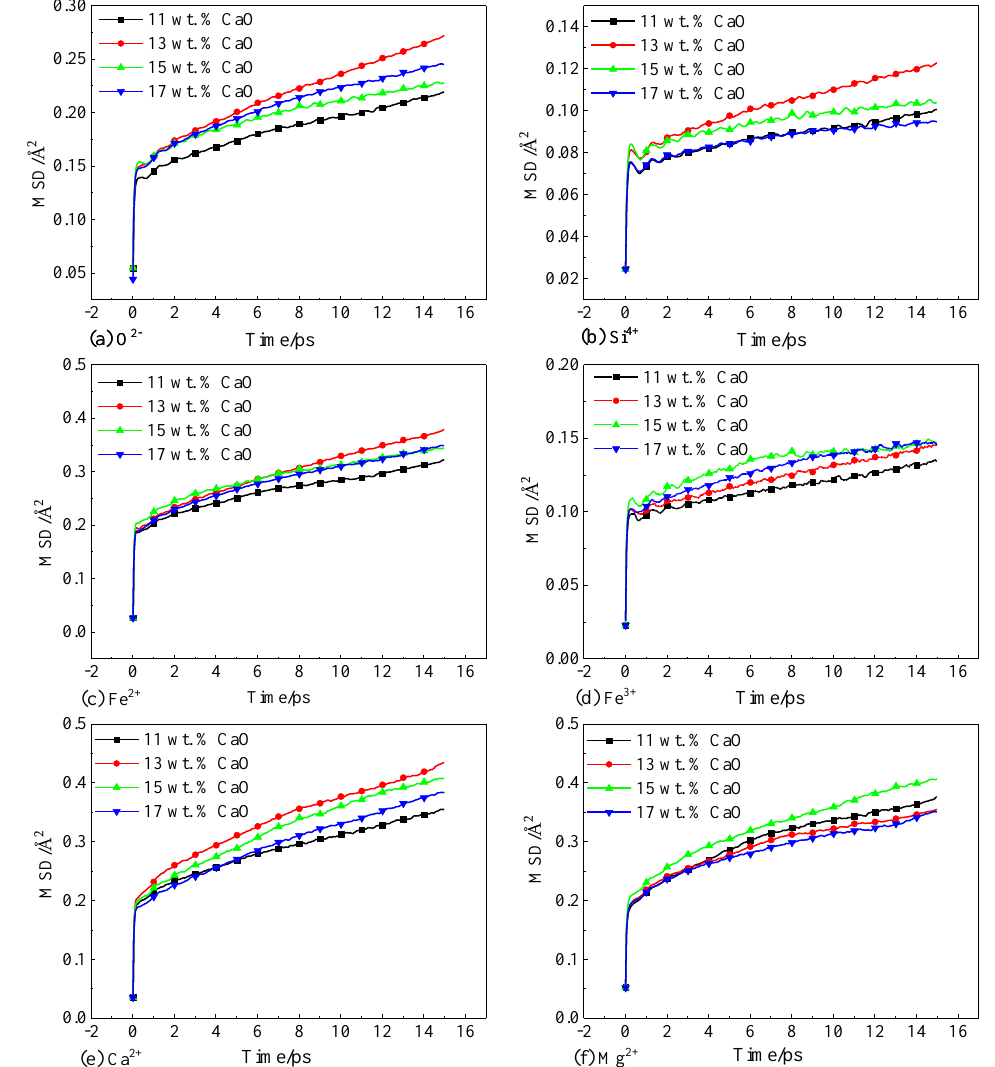
Figure 9. Effect of CaO content on the mean square displacement of ions in nickel slag ( a ) O 2− ; ( b ) Si 4+ ; ( c ) Fe 2+ ; ( d ) Fe 3+ ; ( e ) Ca 2+ ; ( f ) Mg 2+ .